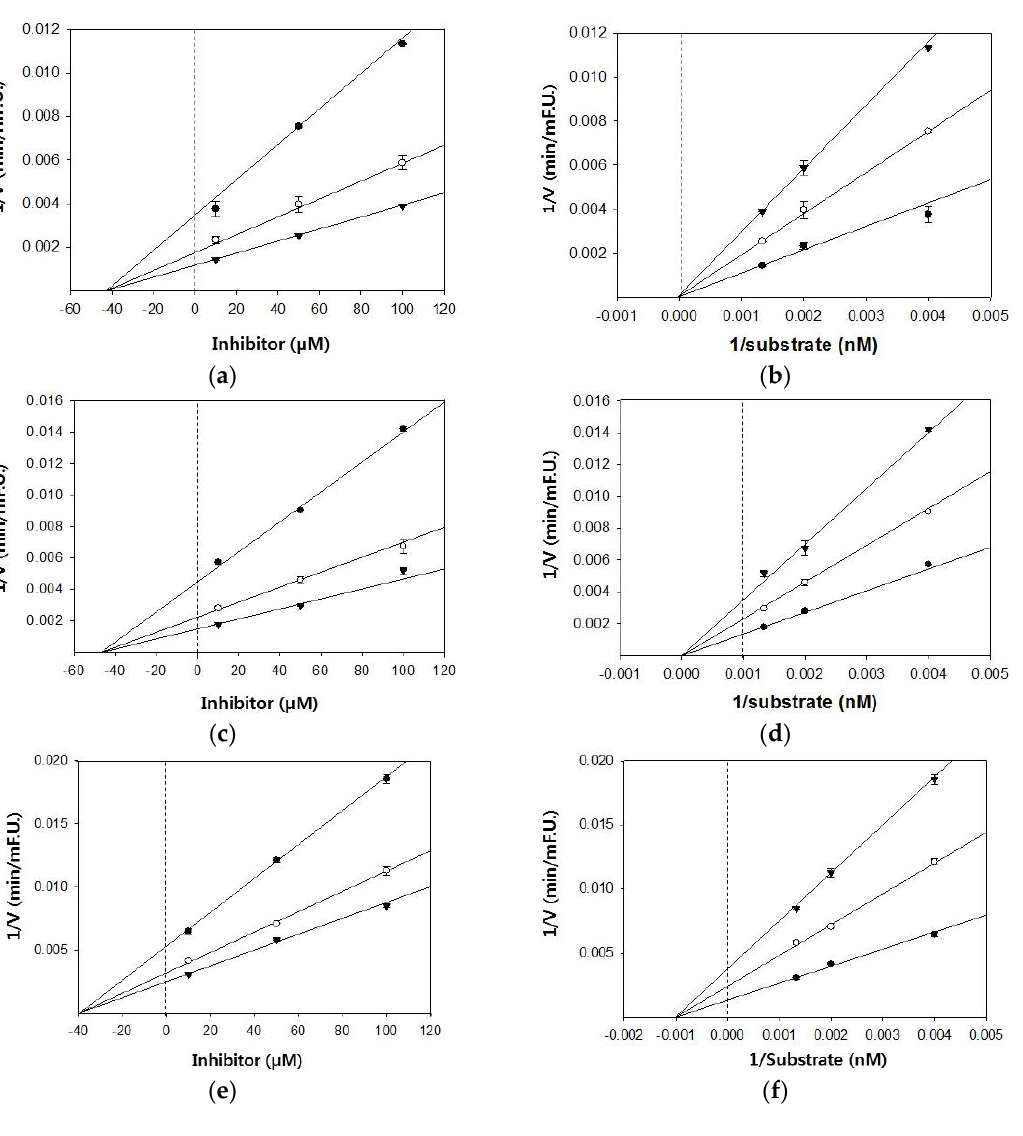
Figure 2. Dixon and Lineweaver–Burk plots for the inhibition of BACE1 by citrus flavanones. Dixon plots show the effects of the presence of different substrate concentrations: 250 nM (●), 500 nM ( ○ ), 750 nM ( ▼ ) for hesperetin ( a ); naringenin ( c ); and hesperidin ( e ). Lineweaver–Burk plots were analyzed in the presence of different inhibitor concentrations: 10 μM (●), 50 μM ( ○ ), 100 μM ( ▼ ) for hesperetin ( b ); naringenin ( d ); and hesperidin ( f ).